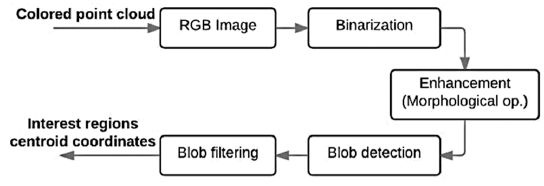
Figure 3. Segmentation process.